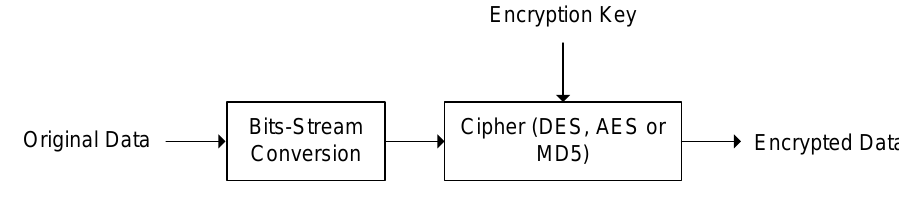
Figure 3. Conventional work of data encryption.